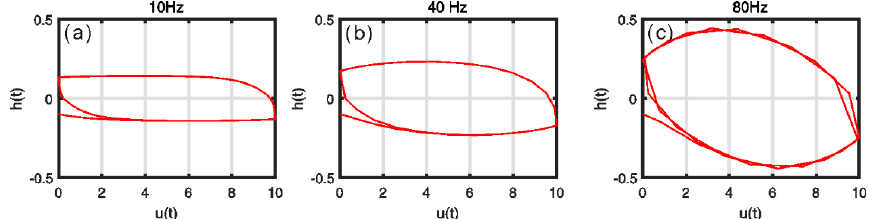
Figure 3. Variations of the component h ( t ) under u ( t ) = 5sin ( 2 π ft ) + 5: ( a ) f = 10 Hz; ( b ) f = 40 Hz; ( c ) f = 80 Hz.